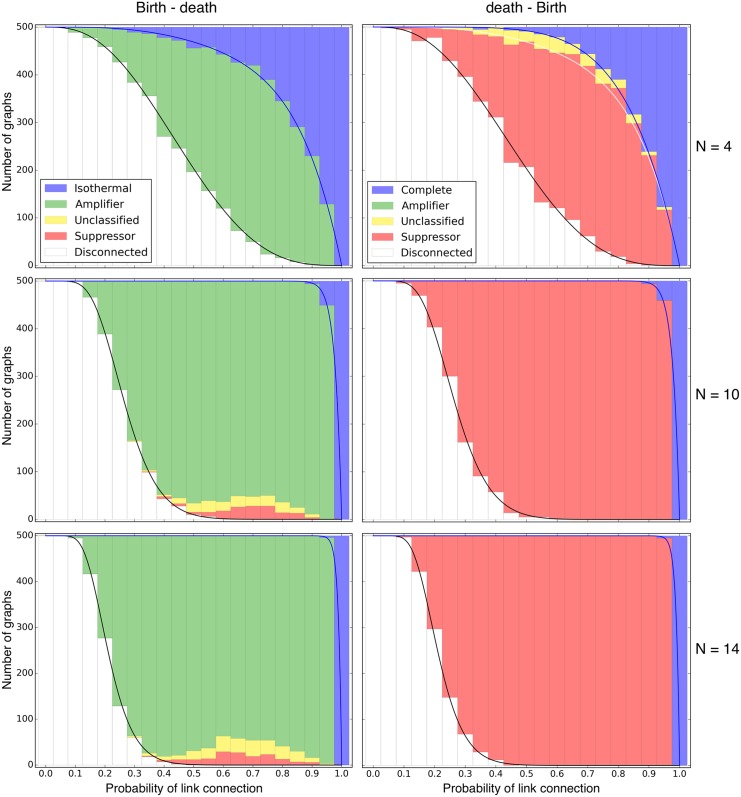
Bd and dB update on undirected random graphs.Fixation probability for the Moran process on undirected random graphs for varying probability of link connection p in Erdős-Rényi graphs. The black line depicts the proportion of connected graphs, given by Eq. (9). In the left panels, the blue line yields the proportion of isothermal graphs. Since the isothermal theorem does not hold for dB [7], in the right panels the blue line depicts only the complete graphs, whereas the white line gives the proportion of cycles for N = 4. Left: For Birth-death updating, most non-trivial graphs are amplifiers of selection and only a tiny fraction are either suppressors of selection or remain unclassified. Right: If the population size is sufficiently large for death-Birth updating, we only find suppressors of selection. The only “unclassified” graph of size N = 4 is the cycle, which is neither an amplifier nor a suppressor of selection for dB, see Eq. (14).